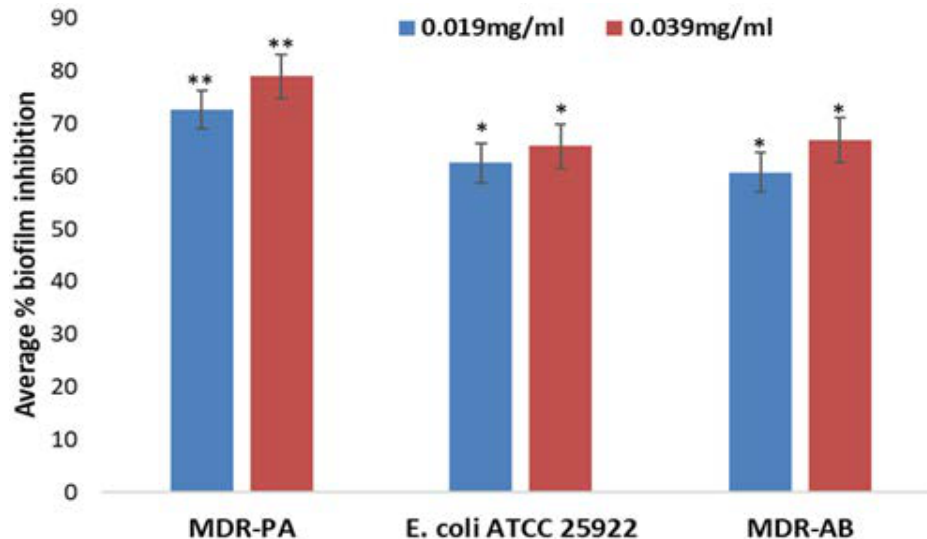
Figure 8. Inhibition of biofilm formation of MDR-PA, E. coli , and MDR-AB caused by AP-AgNPs treatment. The asterisks (**) represent the significance as p < 0.001 and asterisks (*) represent the significance as p < 0.01 against their control experiments by One-Way ANOVA-based Pairwise Multiple Comparison Procedures (Holm-Sidak method), whereas the overall significance level was 0.05.